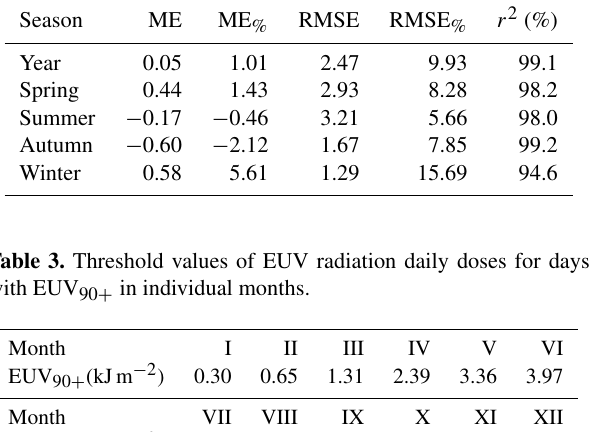
Table 2. Mean error (ME) and its percentage value (ME % ) , root mean square error (RMSE) and its percentage value (RMSE % ) , and the determination coefficient ( r 2 ) for the reconstructed time series and for the individual seasons at the Hradec Králové observatory for 1964–2013. Season RMSE RMSE %